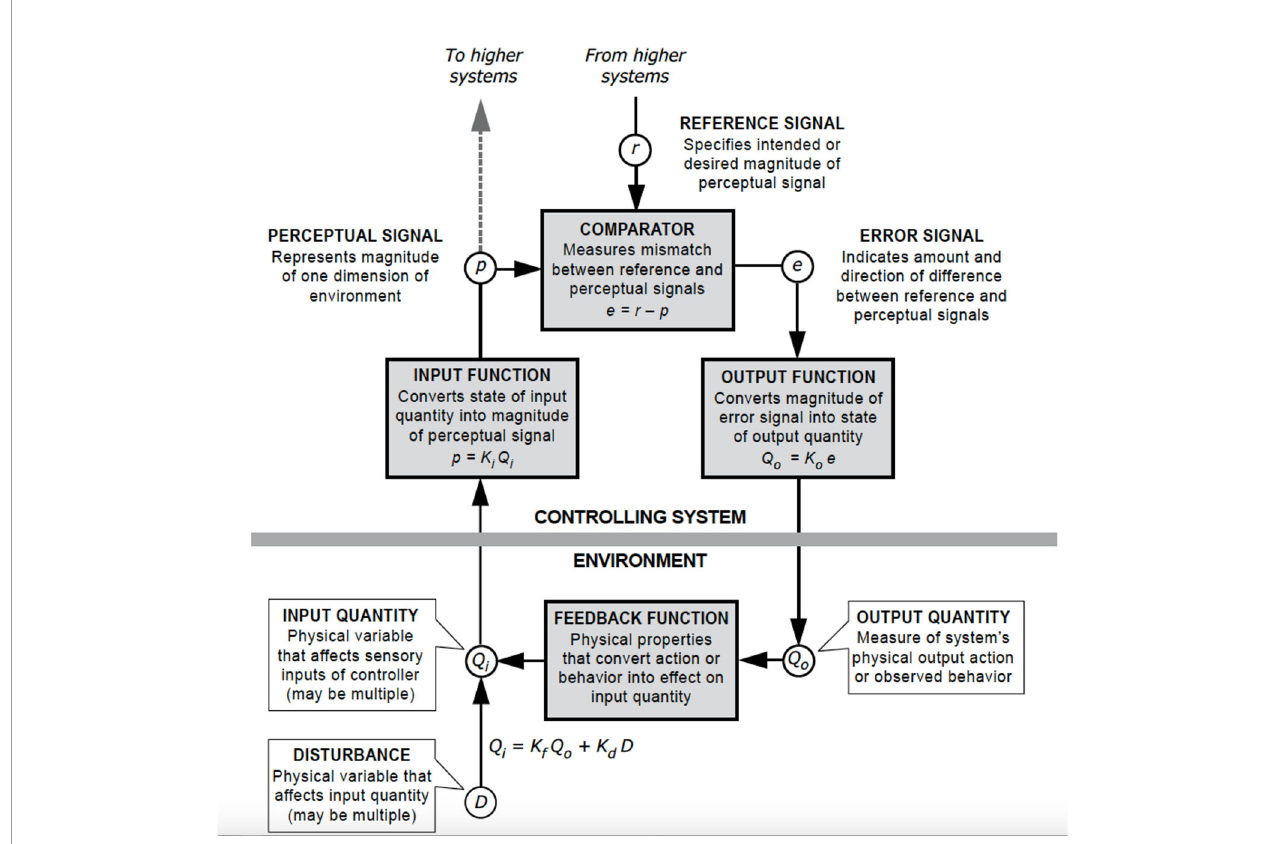
FIGURE 1 | Diagram of the control unit according to perceptual control theory. Permission granted from Dag Forssell, redrawn from an original fi gure by William T.